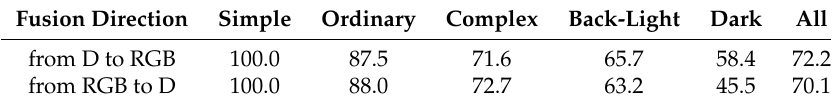
Table 3. The AP of Ours w/o reconstruct with different fusion directions. The default direction is “from D to